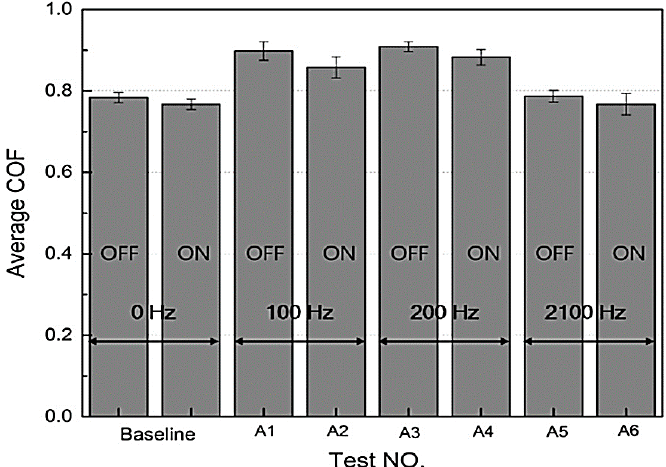
Figure 18. The Plot of the average coefficient of friction as a function of various vibration frequencies [34] (reprinted with permission from Elsevier TM ).